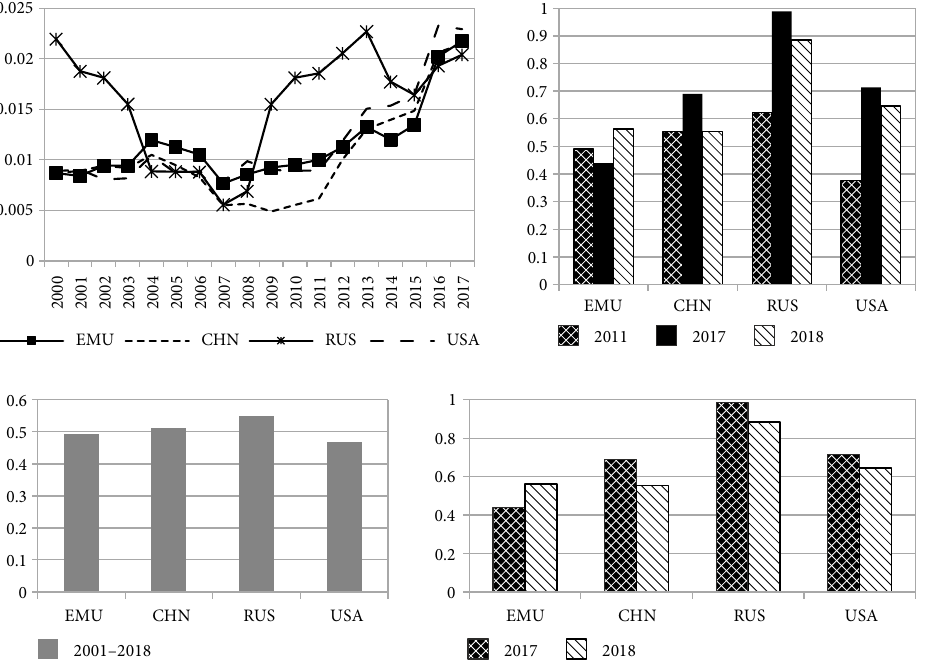
Figure 2. Business cycles asymmetry between Iran and each major trade partner (constant 2010 in USD) (source: own research based on WDI,